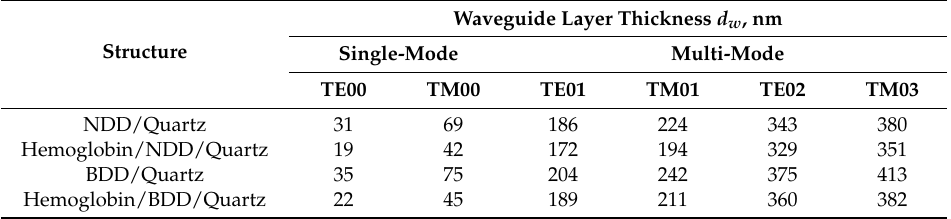
Table 2. The critical thickness of waveguide layer for waveguide